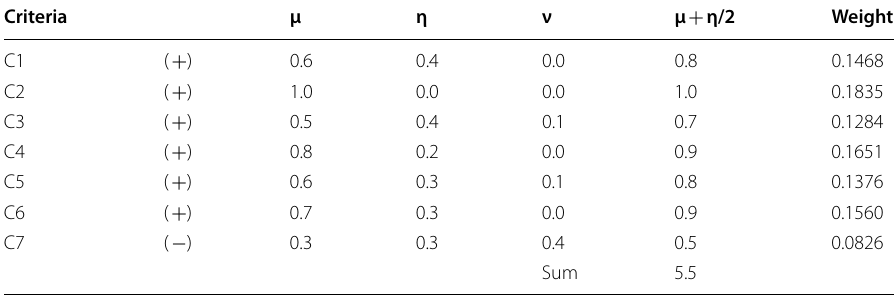
Table 6 Criteria weights